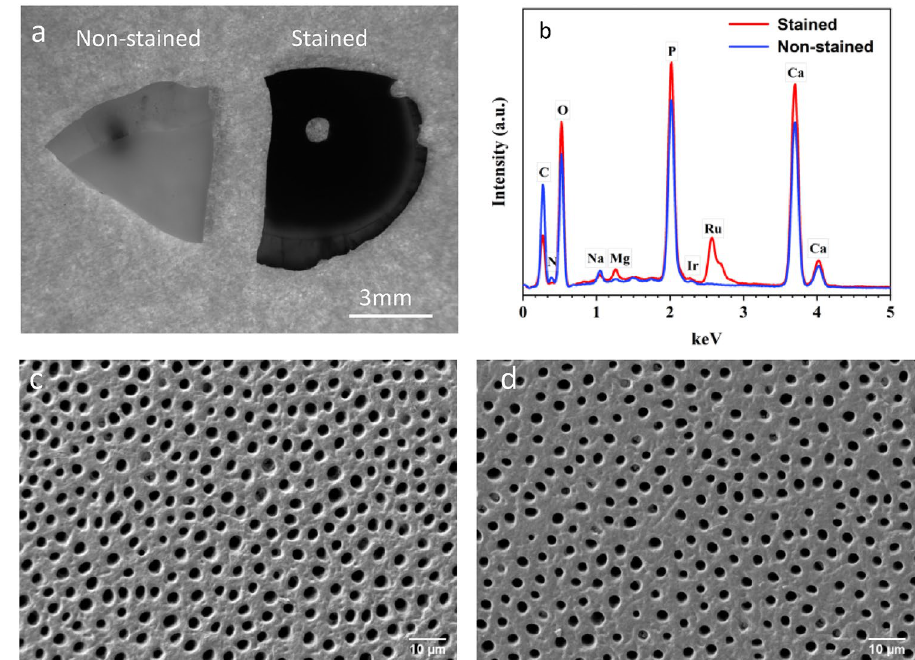
Figure 2. ( a ) Optical micrograph and ( b ) EDS spectrum of the non-stained and stained dentine disk. SEM image of the top surface of the ( c ) non-stained and ( d ) stained dentine disk.